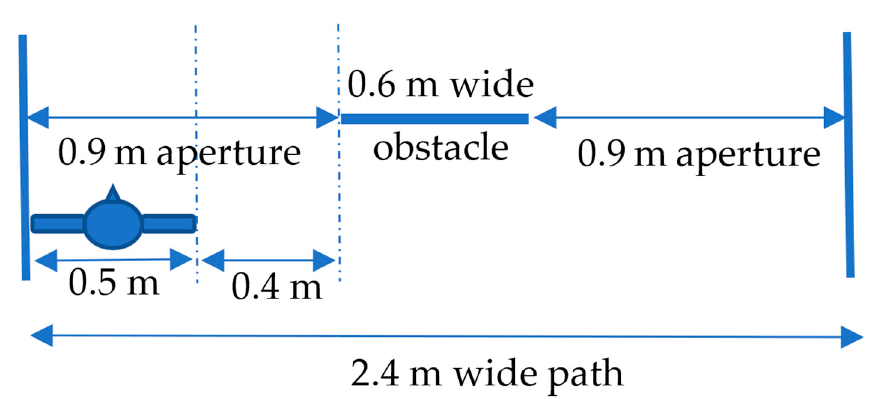
Figure 6. Schematic top view of the experimental setup illustrating the parameters used for compu- ting the probability of passing the apertures without collisions by chance. ing the probability of passing the apertures without collisions by chance. Table 3. Probability of a given score with a random trajectory.